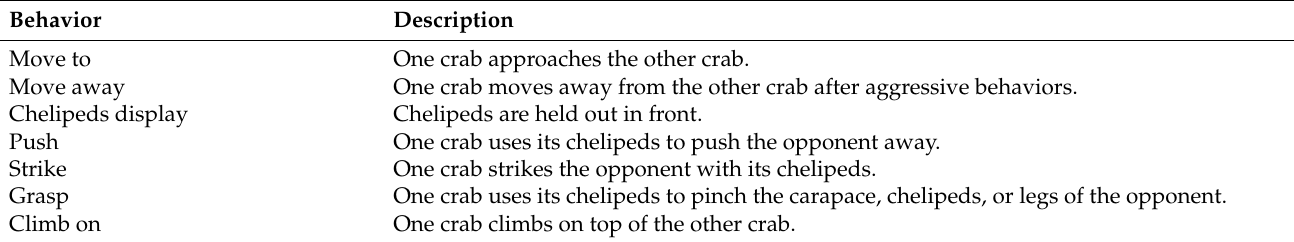
Table 2. Description of aggressive